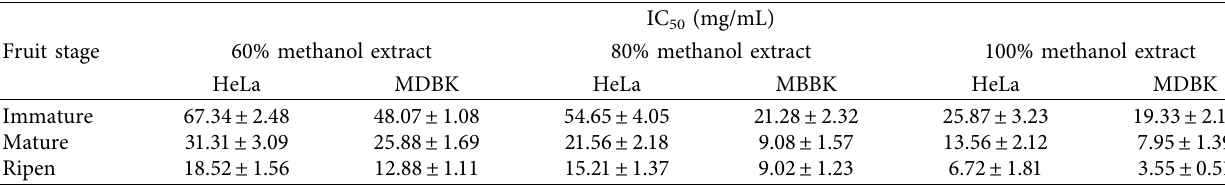
Table 4: IC 50 values calculated for anticancer activity of immature, mature, and ripen BG extracts in 60%, 80%, and 100% methanol using HeLa and MBDK cancer cell